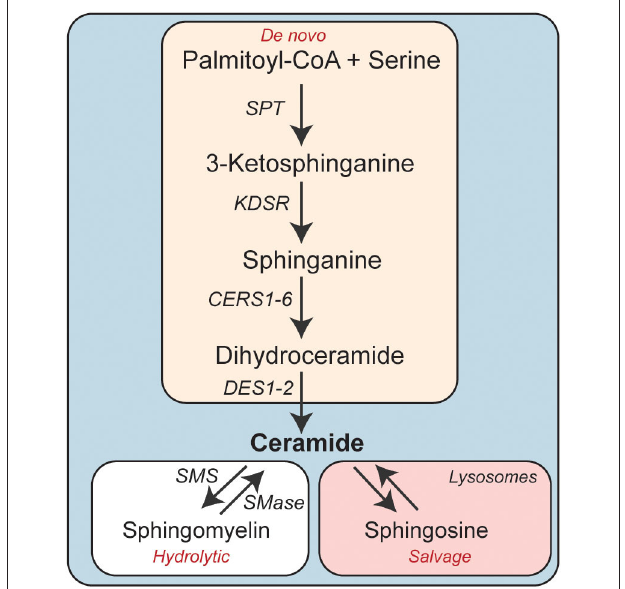
FIGURE 1 | Schematic depicting the enzymatic pathways involved in cellular ceramide synthesis. CERS, Ceramide synthase; DES, Dihydroceramide desaturase; KDSR, 3-ketodihydrosphinganine reductase; SMS, Sphingomyelin synthase; SMase,